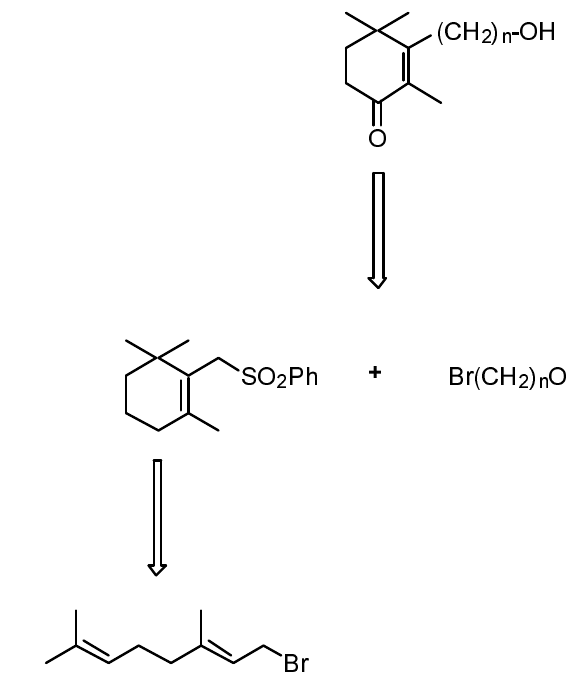
Figure 5. Retrosynthetic analysis of t-CFAs ( 12 ).